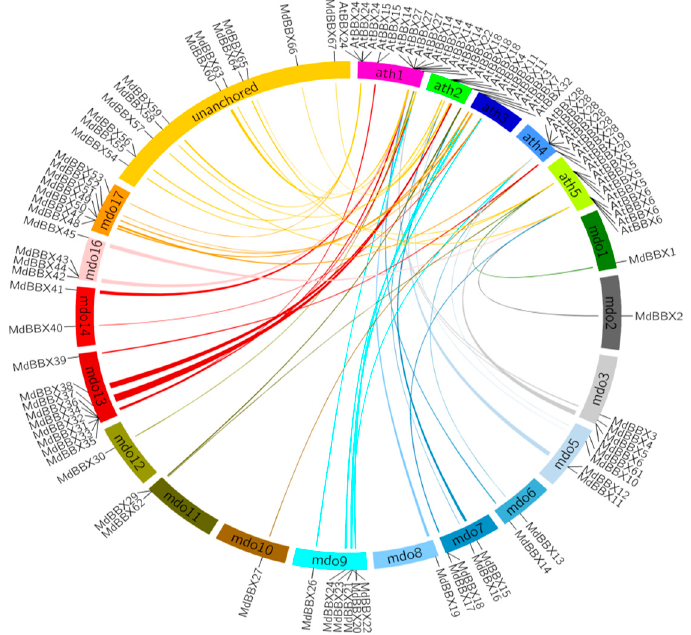
Figure 6. Synteny analysis of apple and Arabidopsis BBX genes. Chromosomes of apple and Arabidopsis are shown in different colors and in circular form. The approximate positions of the AtBBX and MdBBX genes are marked with a short black line on the circle. Colored curves denote the syntenic relationships between Apple and Arabidopsis BBX genes.